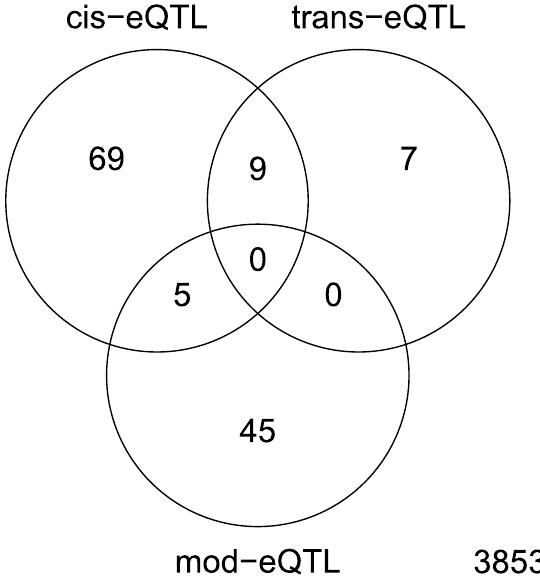
Figure 3. Venn diagram showing the overlap of genes differentially expressed (from the 3,987 investigated) associated with the different eQTL types ( cis , trans and modified). The numbers represent the number of genes differentially expressed associated with the different types of eQTLs: cis -eQTLs, SNPs in promoter regions, transcriptional start sites (TSS), upstream (up to − 200 bp) or within the gene; tr -eQTLs, potentially impairing non-synonymous SNPs located in transcriptional regulators; and mod -eQTLs, methylated bases located either within the gene or upstream including promoter regions and